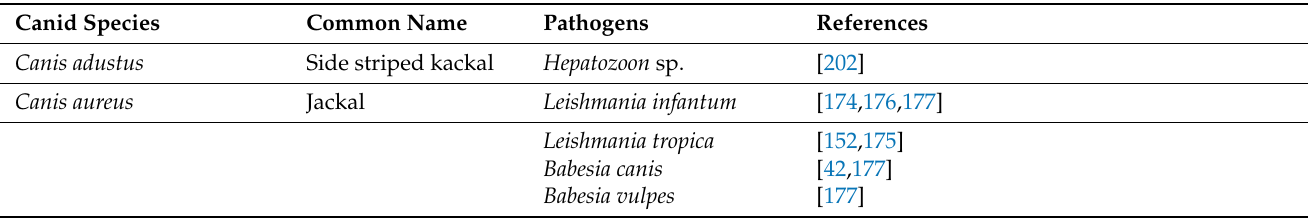
Table 2. Molecular detection of protozoal arthropod-borne pathogens in wild canids in relation to the animal